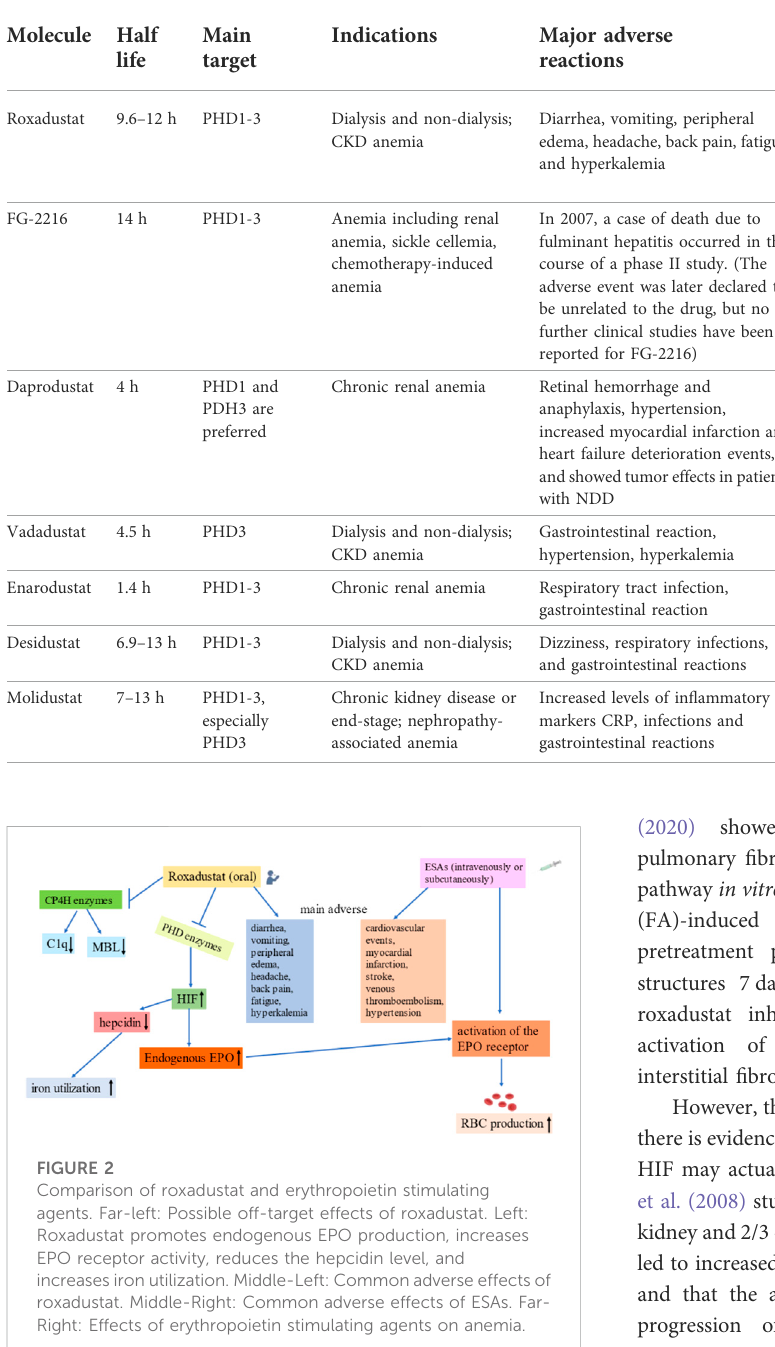
TABLE 1 The PHD inhibitors have been trialled in Humans.